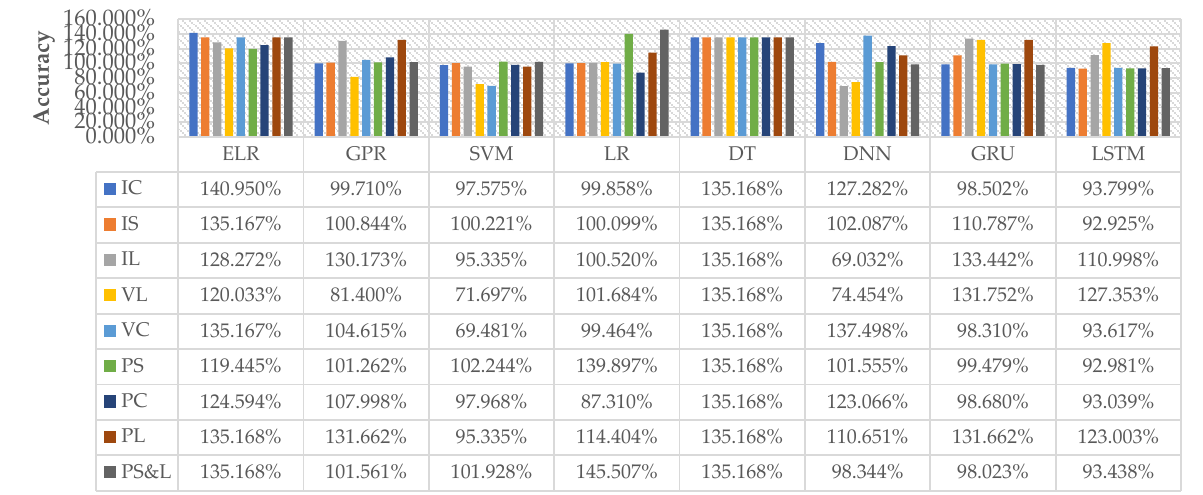
Figure 14. Average accuracy of the estimated equivalent series resistance ( ESR ) using discrete wavelet transform (DWT) analysis.